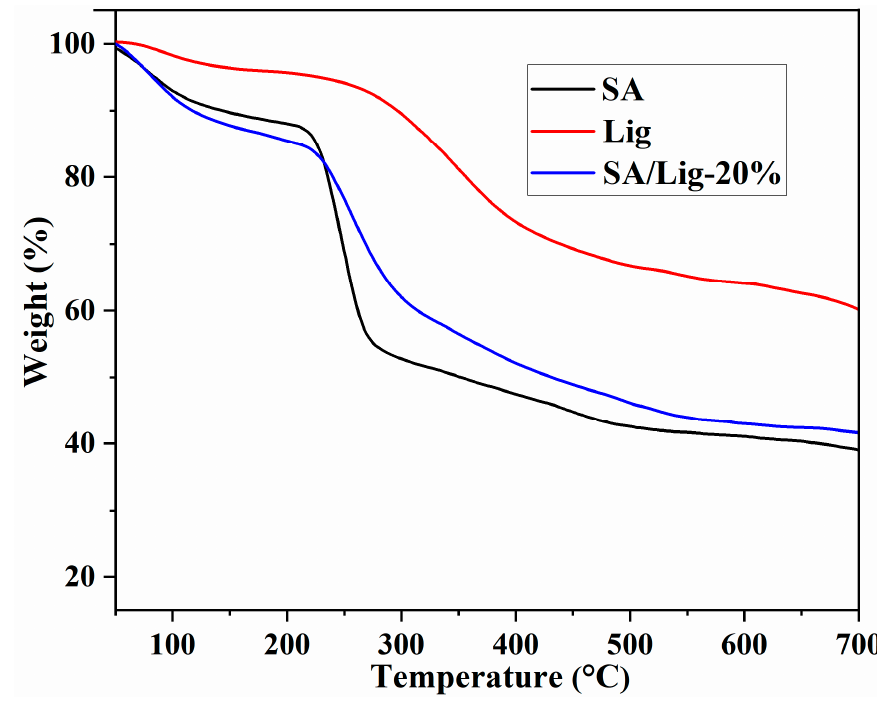
Figure 3. TG spectra of SA, Lig, SA/Lig-20% beads.